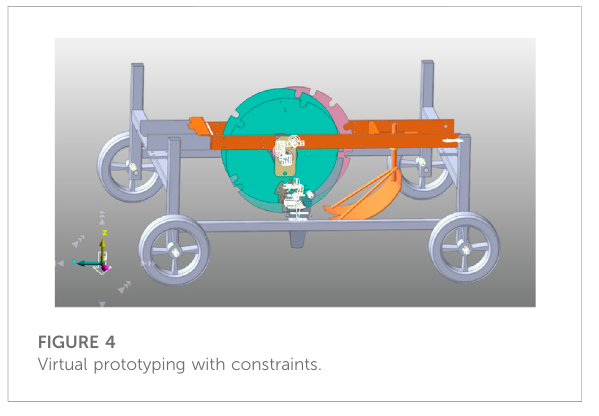
FIGURE 4 Virtual prototyping with constraints.